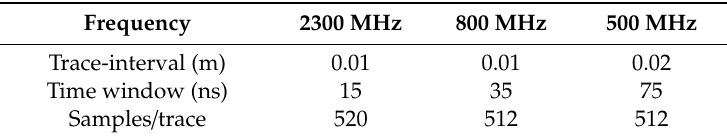
Table 2. Filters and parameters used for GPR data processing.